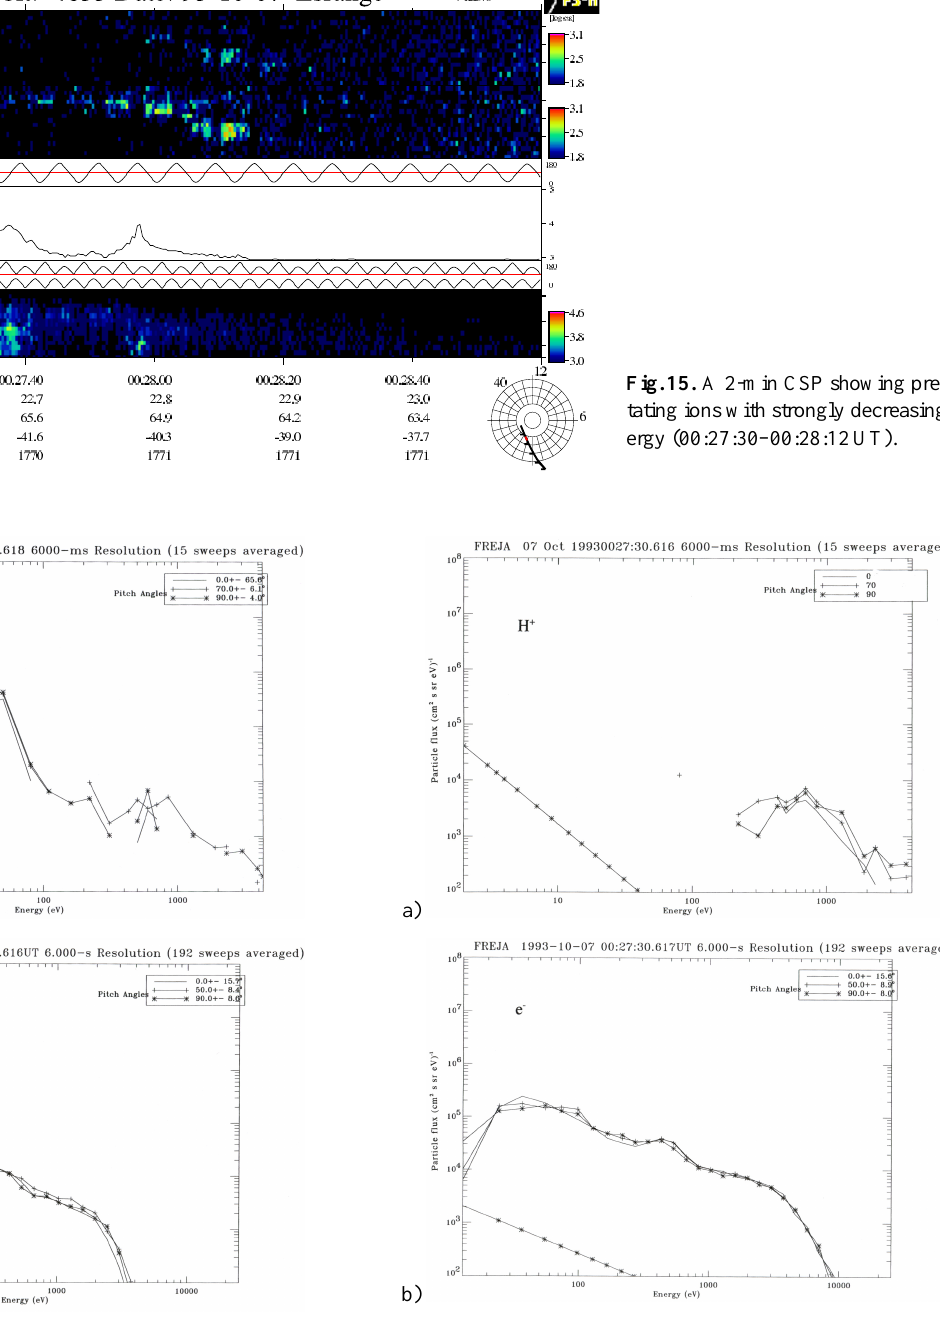
Fig.17. Measured energy spectra of H + ions (a) and electrons (b) before the ion energy started to decrease in Fig.15. same period, the H + ions increased strongly in energy, as il- lustrated by Figs. 19a and 20a. At 03:42:25 UT the energy spectrum surpassed the upper energy limit of the ion spec- trometer (4.5 keV). (Results are given in counts in order to illustrate the level of statistical